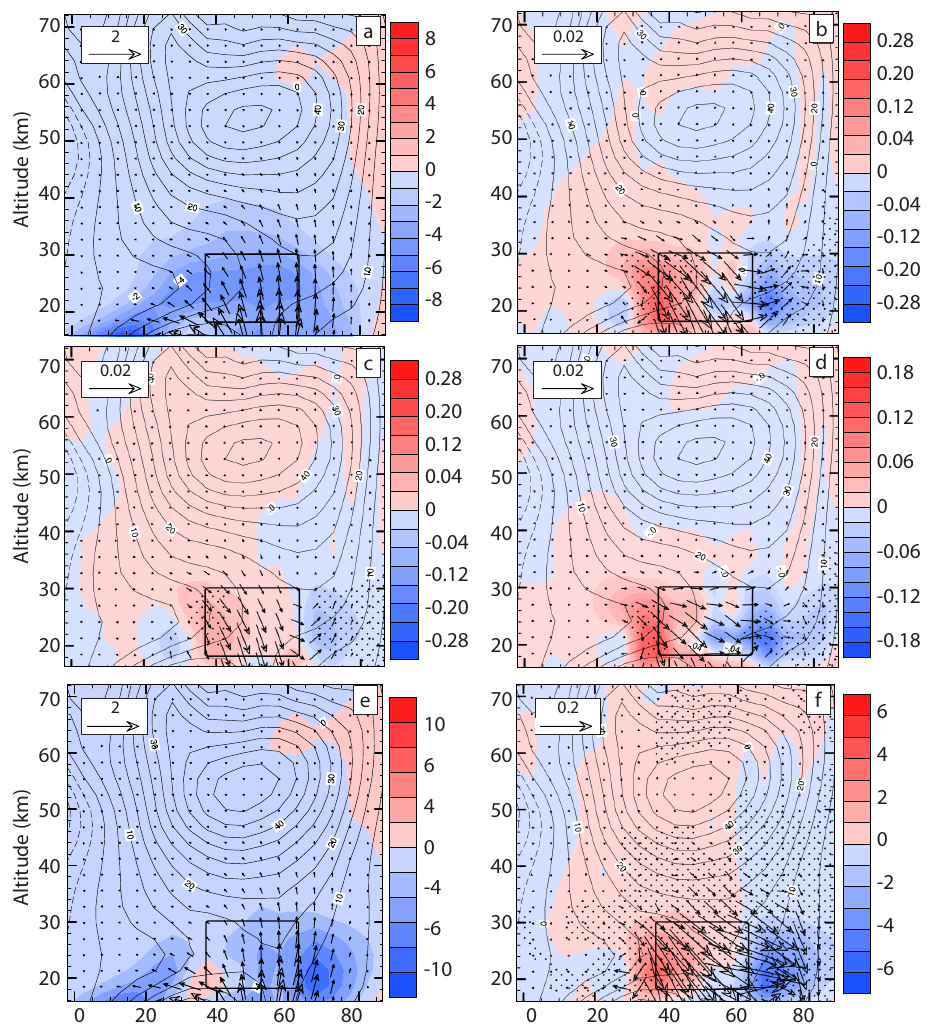
Figure 7. Mean E–P flux vectors (kgs − 2 ; arrows are scaled according the relative distances of the plot) and its divergence (colours in kgm − 1 s − 2 ) for Box0.1 (a) , its anomalies (b) , Zon0.1anomalies (c) , difference between the Box0.1 and Zon0.1 simulation (d) , mean E–P flux and its divergence for 10box (e) and its anomaly (10box–reference; f ). Note that scales are adjusted for each subfigure, except the plots of anomalies ( b , c ) sharing the same scaling. In panels (a) – (f) contours of zonal-mean zonal wind from the respective simulations are overlaid with an increment of 10ms − 1 . All panels are overlaid with selected contour of gravity-wave-induced zonal acceleration to illustrate the location of artificial GWD. The statistical significance of the mean E–P flux divergence differences was computed by a t test and regions with p values < 0 . 05 are